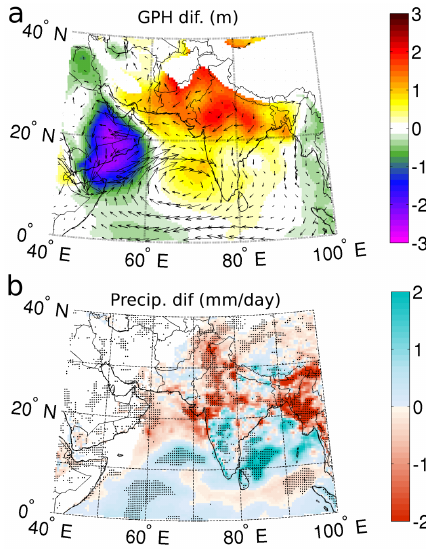
Figure 11. Dust impact on the mean monsoon dynamic and pre- cipitations over the period JJAS 2000–2009. (a) 850hpa geopoten- tial heights (GPH) and monsoon circulation dust-induced anomalies calculated as the GPH difference between dust and nodust simula- tions. (b) Dust-induced precipitation anomaly. The dotted region defines statistically significant results at the 95% confidence level. All modeling results represent a three-ensemble-member